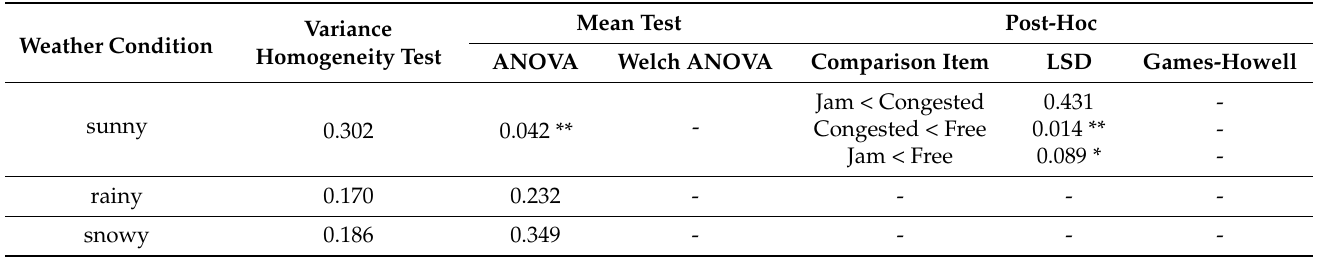
Table 7. The significance test of the influence of traffic flow conditions on the minimum time headway.